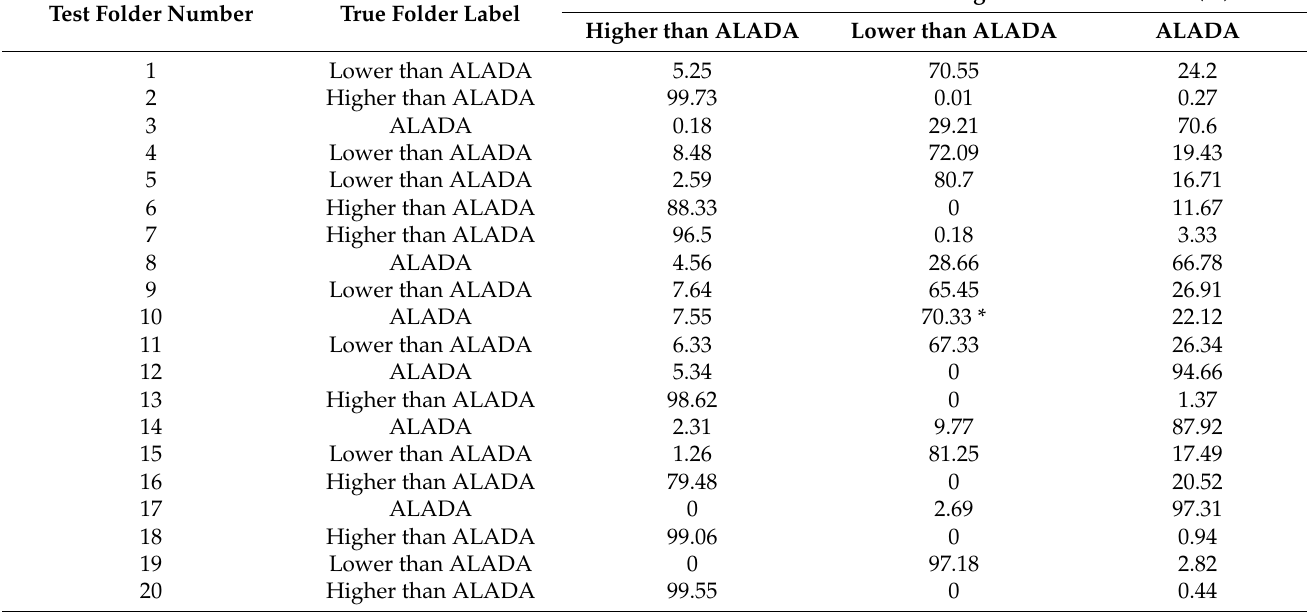
Table A2. Model 3DM2 (cid:48) s designation of the dose levels (labels) of the individual image sections within the test MDCT dataset folders. ALADA: as low as diagnostically